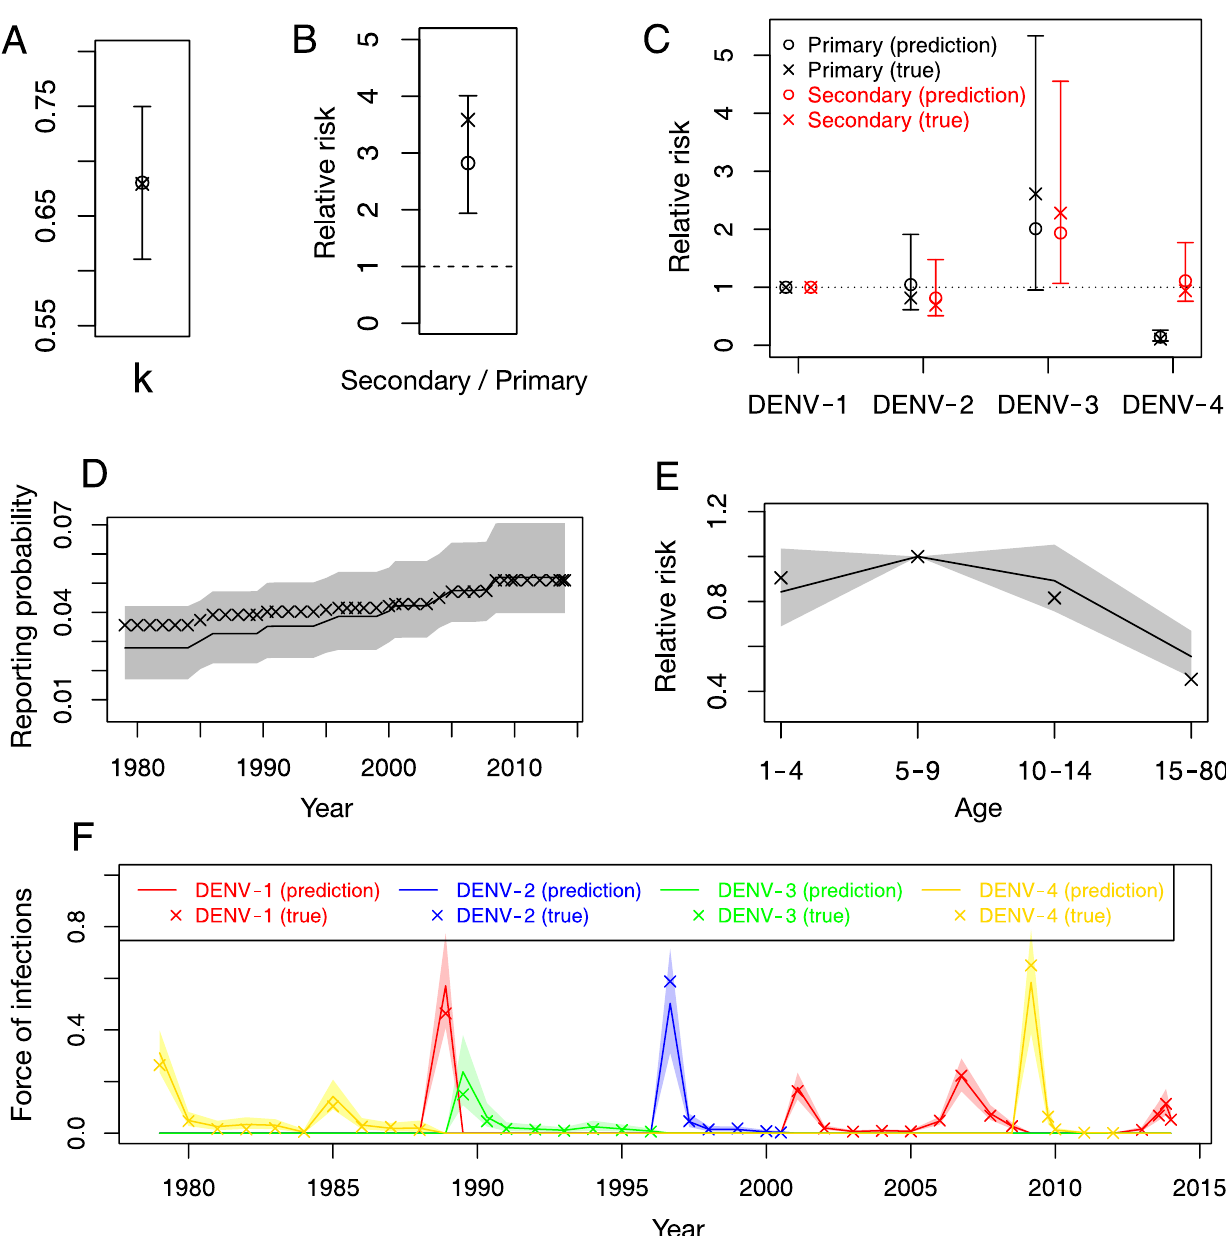
Fig 6. Evaluating the Bayesian inference using synthetic data. Using the model described in the main text, we generate synthetic data for given model parameters. Using this synthetic data, we then infer the model parameters using the Bayesian inference. The original parameters are plotted as crosses (true), while the inferred results are plotted as lines or circles with 95%-CIs (predictions). In (A), the parameter k for the negative binomial distribution is shown. In (B), the relative strength of the reporting probabilities of secondary infections (DENV-1) compared with primary infections (DENV-1) φ (1,2)/ φ (1,1) is shown. In (C), the reporting probabilities relative to serotype 1, φ (i,1)/ φ (1,1) for primary infections and φ (i,2)/ φ (1,2) for secondary infections, are shown. Here i = 1,2,3,4 corresponds to DENV-i. In (D), the reporting probability of primary infections by DENV-1 T(t) is shown as a function of time. In (E), the age-factor of the reporting probability A(a) is shown. In (F), the FOI is shown as a function of time.